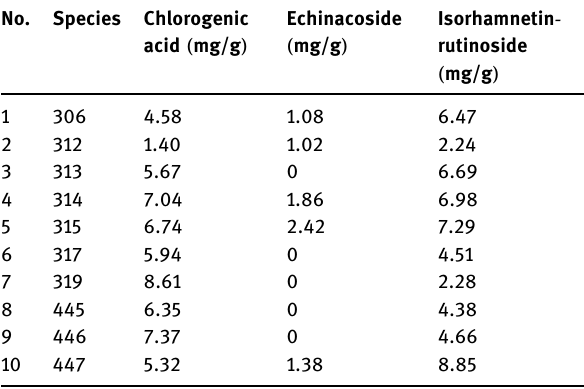
Table 4: The contents of three inhibitors in ten jute